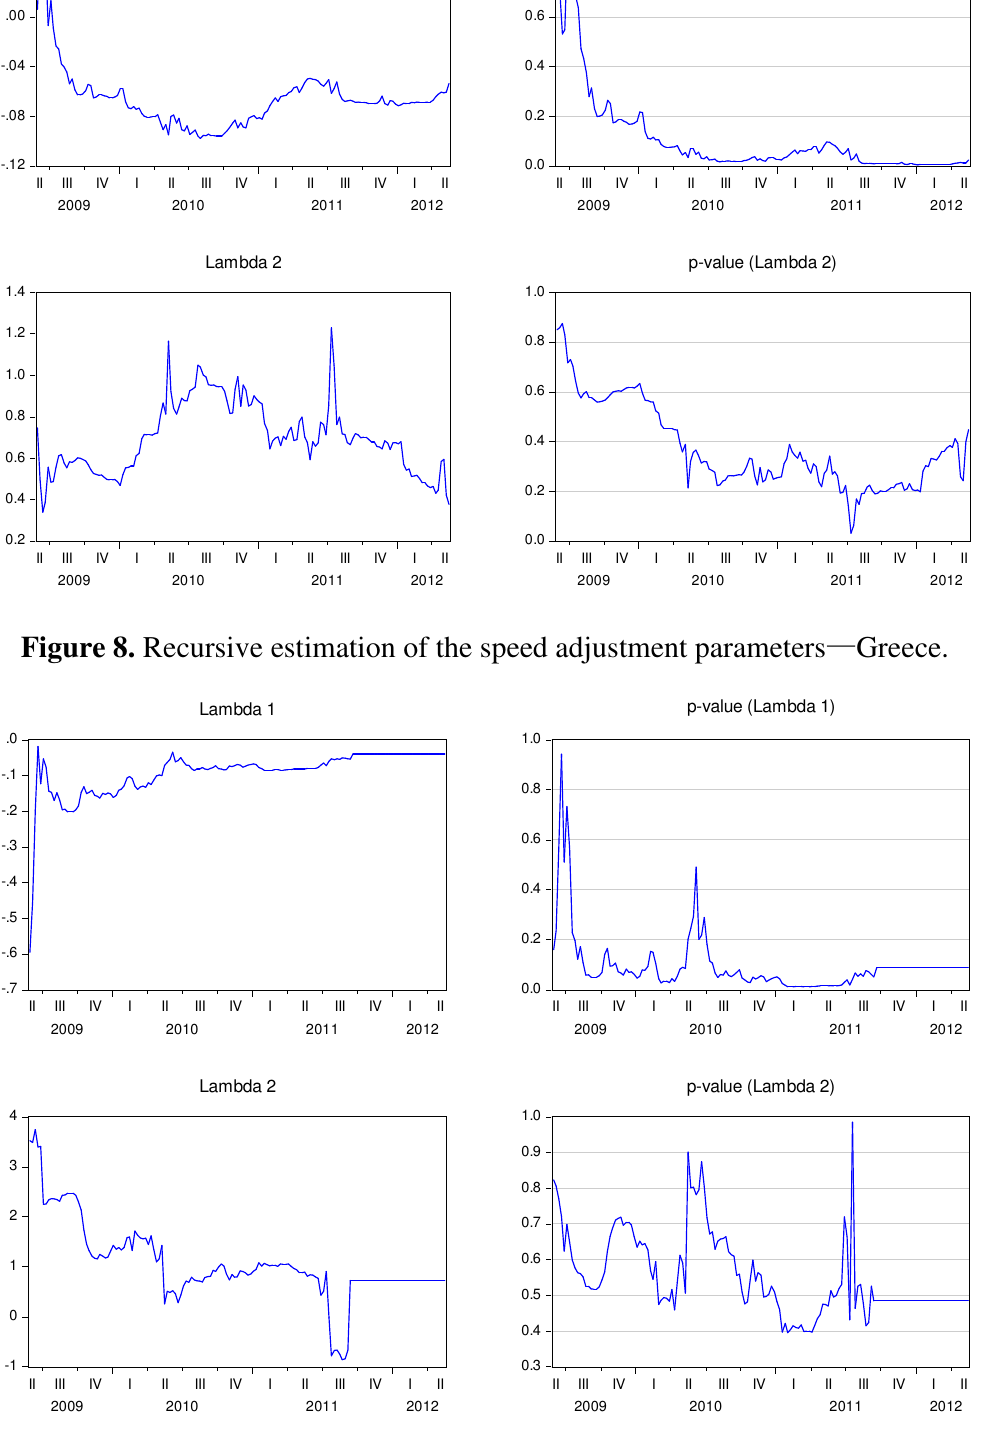
Figure 7. Recursive estimation of the speed adjustment parameters — Portugal.